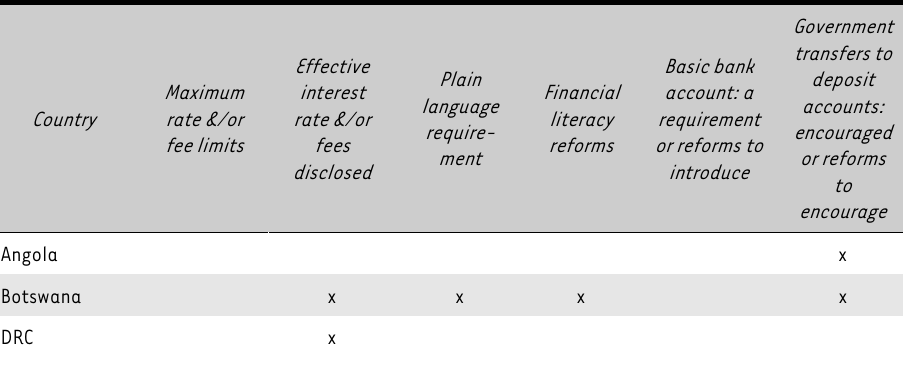
Government policies and regulations impacting on bank access and use, 2009